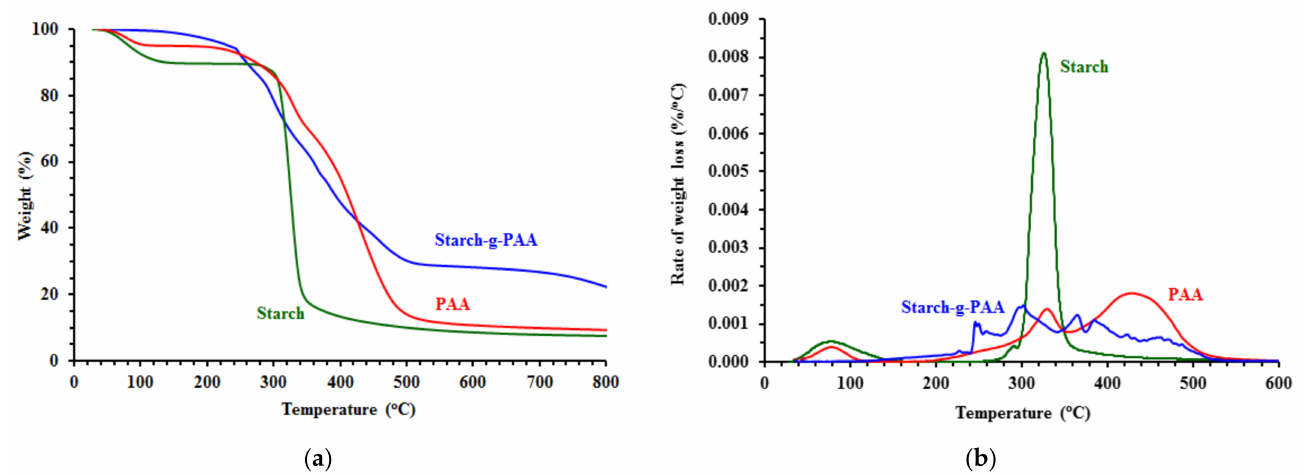
Figure 5a,b show that thermal degradation of starch occurred in two major